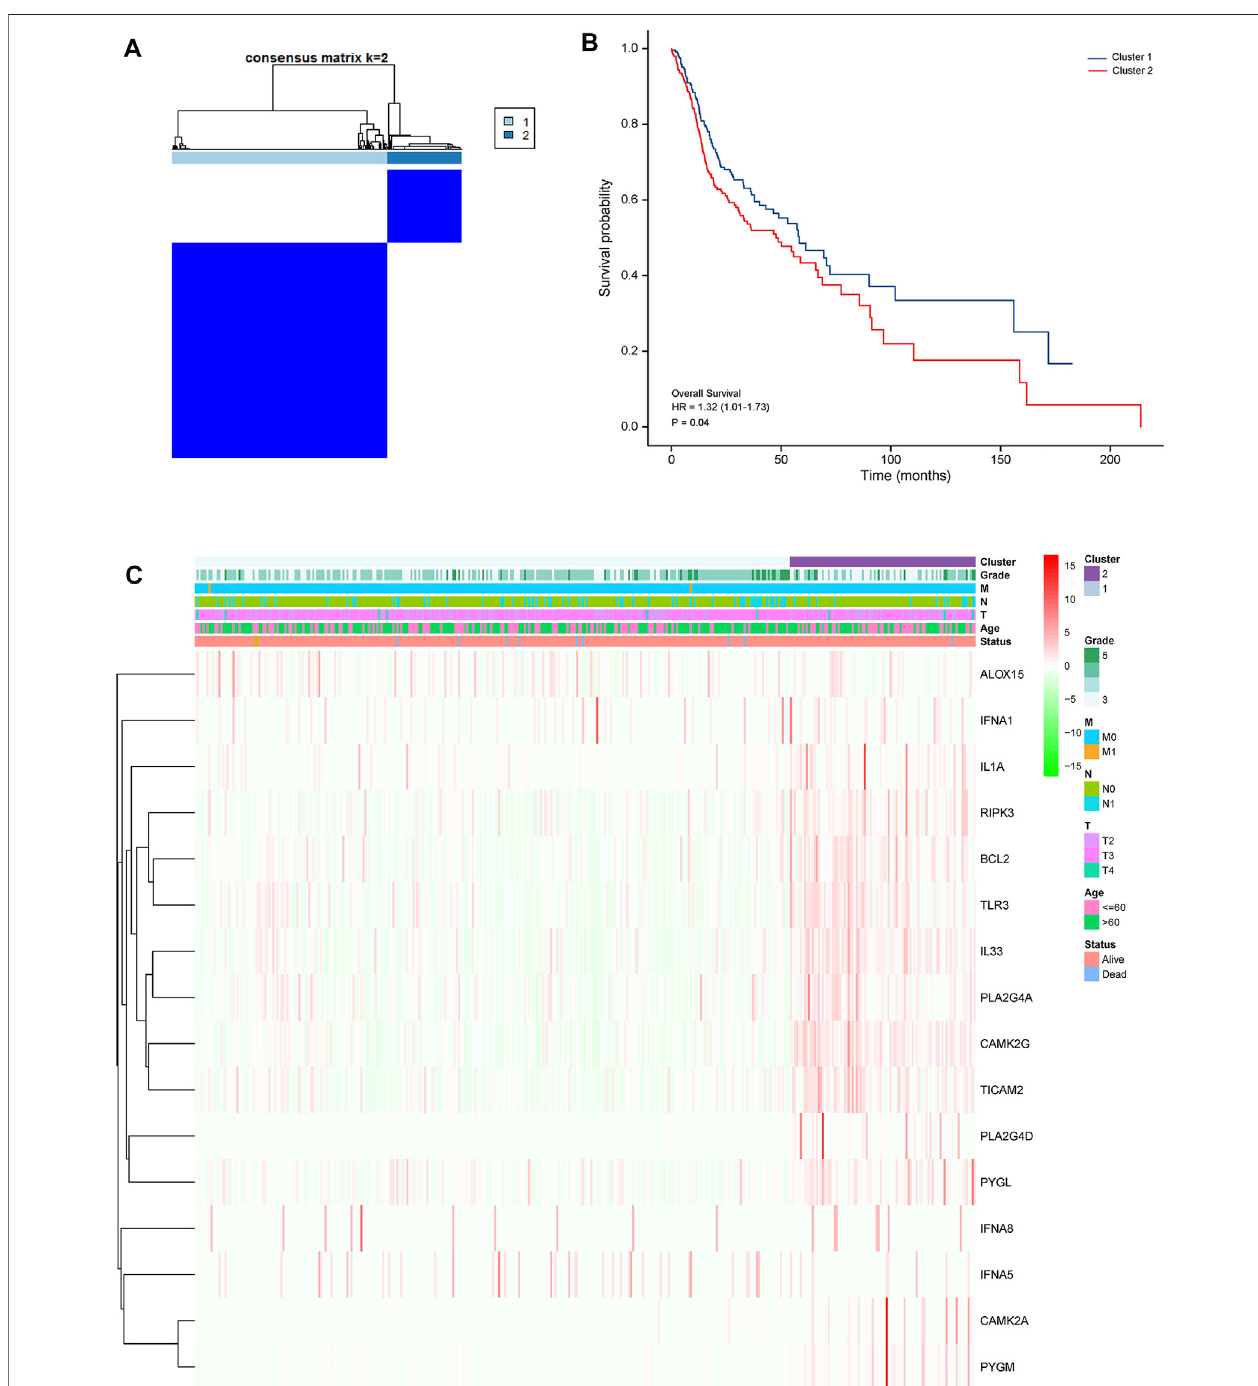
FIGURE7| Tumorclassi fi cation based onthe identi fi ed pyroptosis-relatedDEGs (A) .Patients were grouped into2clusters according totheconsensus clustering matrix (k (cid:1) 2). (B) . Kaplan – Meier curves showing OS ofpatients in the2 clusters. (C) . A heatmap and clinicopathologic characteristics ofpatientsin the 2 clustersbased on the identi fi ed